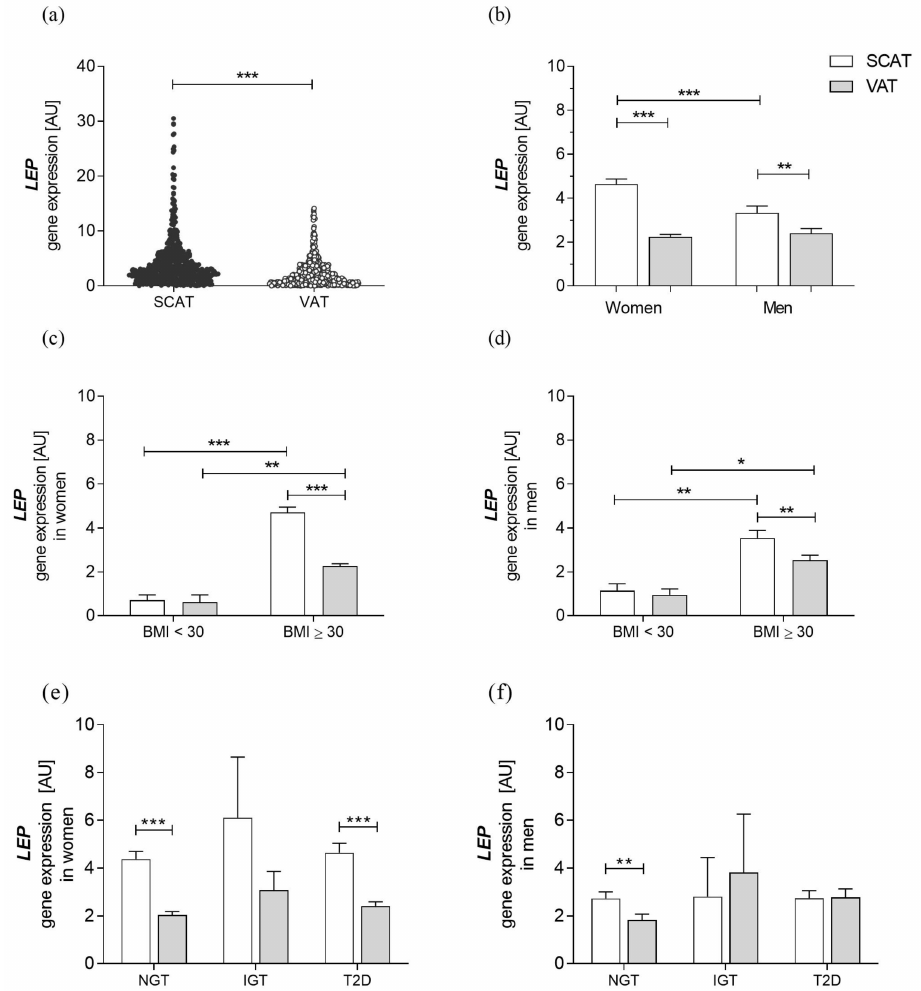
Figure 1. Characterization of LEP gene expression. LEP gene expression in ( a ) the entire cohort (N = 585) in subcutaneous (SCAT) and visceral (VAT) adipose tissue, ( b ) SCAT and VAT separated by sex (N = 429 in women, n = 156 in men), ( c , d ) obese patients (BMI ≥ 30 kg/m 2 ; N = 420 in women, N = 143 in men) in comparison to the control group (normal weight and overweight individuals with BMI < 30 kg/m 2 ; N = 6 in women, N = 14 in men) in SCAT and VAT respectively and ( e ) individuals with different degrees of glucose intolerance (for NGT N = 190 in women, N = 73 in men; for IGT N = 10 in women, N = 3 in men; for T2D N =157 in women, N = 68 in men). Group comparing analysis was performed on ln-transformed data by two-sided t -test or Welch’s test in case of unequal variances for ( a – d ) and by ANOVA with posthoc Bonferroni test for ( e , f ). Data are shown as mean ± SEM. * p < 0.05; ** p < 0.01; *** p < 0.001. NGT: normal glucose tolerance; IGT: impaired glucose tolerance; T2D: Type 2 Diabetes